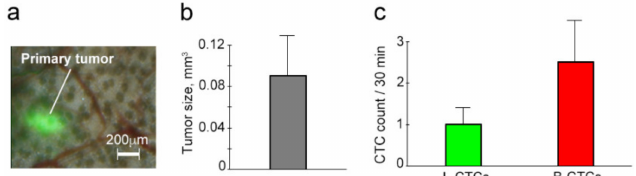
Figure 8. Assessment of mice with early breast cancer. ( a ) Integrated transmission and fluorescence image of primary breast cancer in the mouse ear. ( b ) Primary tumor size. ( c ) The average counts of L-CTCs in a ff erent lymphatic vessels and B-CTCs in ear blood vessels. Results in “b” and “c” panels are presented as means ±